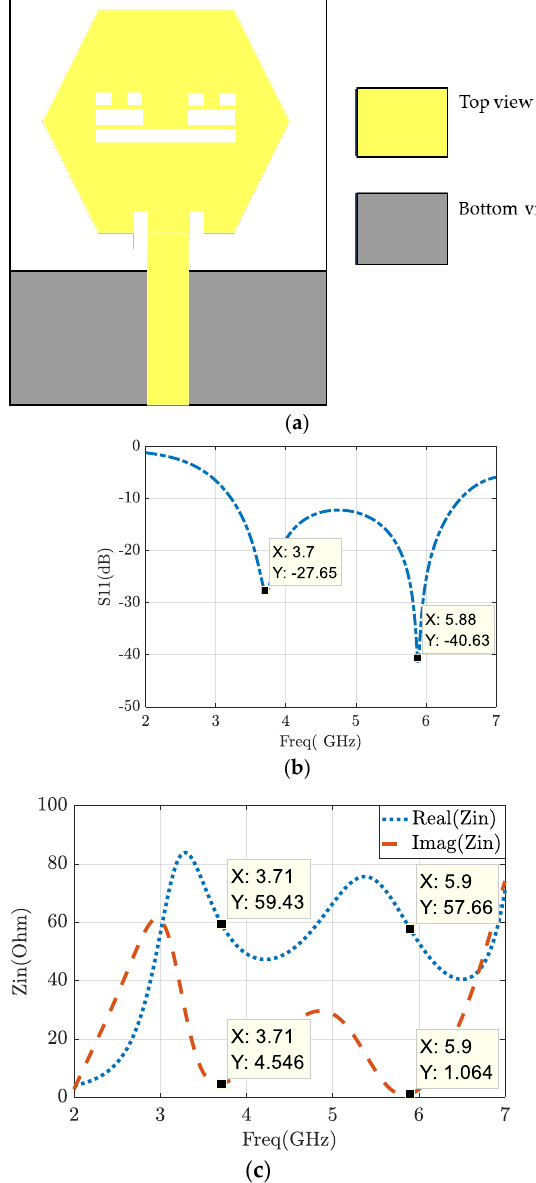
Figure 1. ( a ) Case study antenna; ( b ) the simulated antenna S11 (dB) versus frequency; ( c ) antenna- simulated impedance (Ohms).